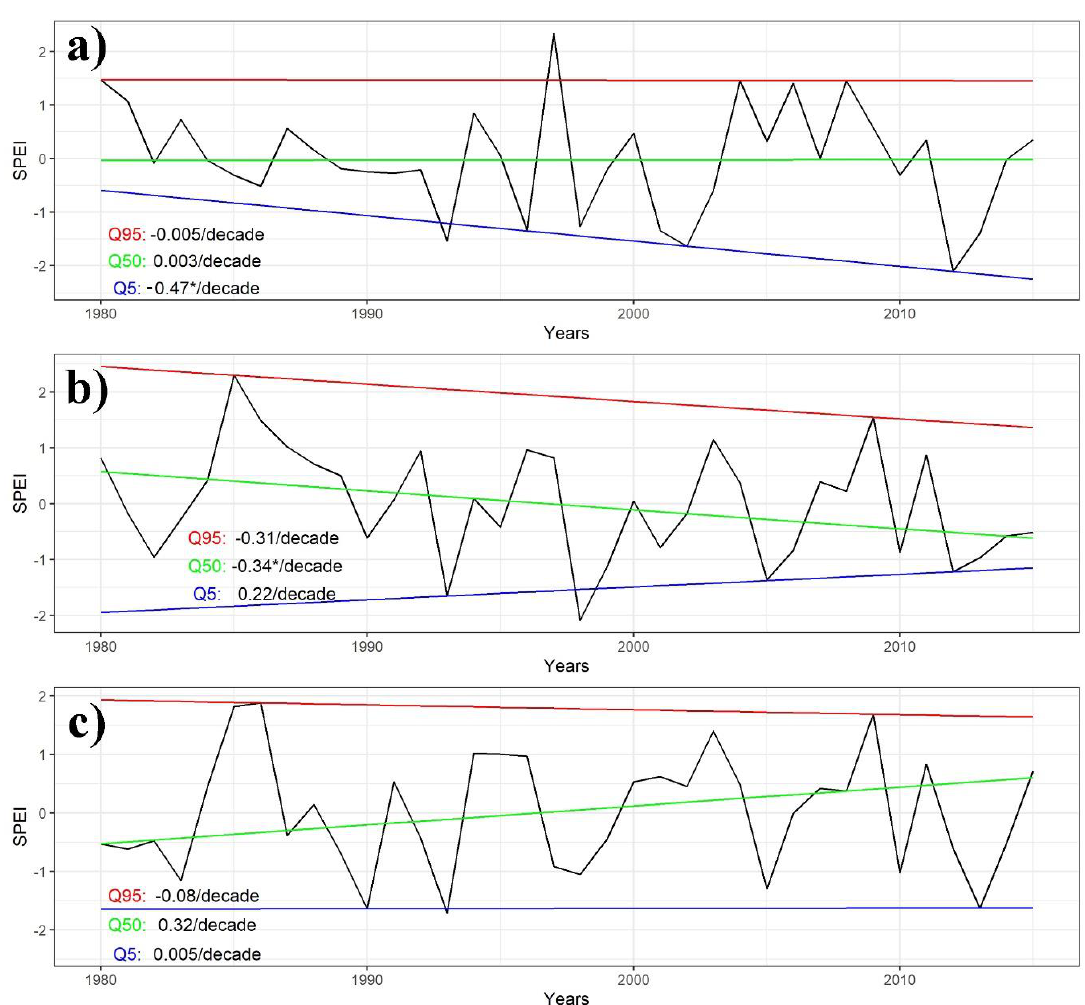
Figure 5. Trends of SPEI-3/decade multi quantile levels for the FMA quarter in the cities ( a ) Barreiras (BA), ( b ) João Pessoa (PB), and ( c ) Fortaleza (CE). * Confidence interval used: 95%.